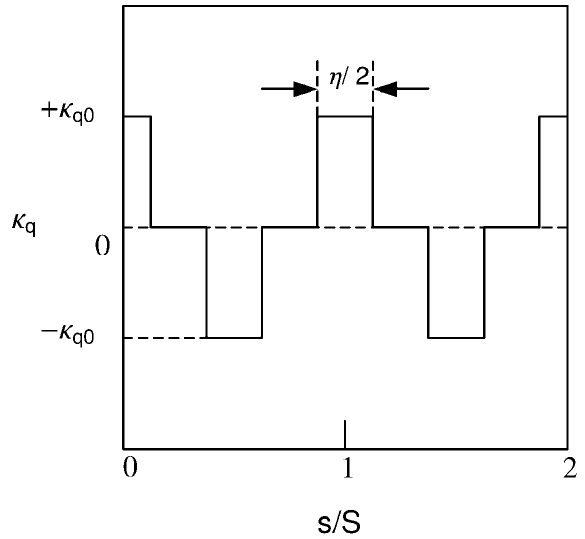
(cid:2) s (cid:3) q